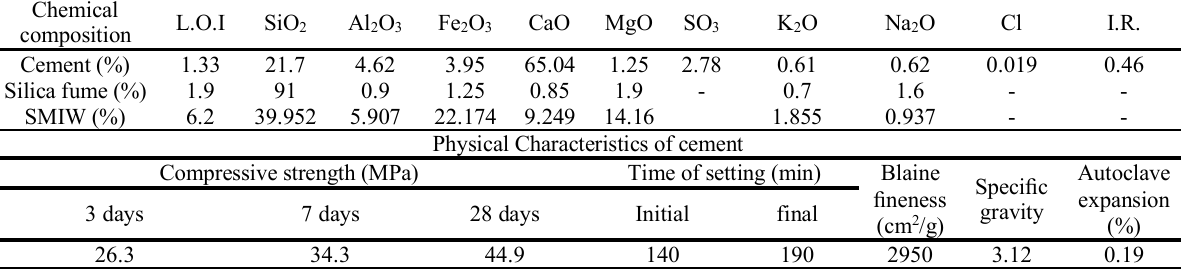
Table 1. Chemical composition and physical properties of cement, silica fume and